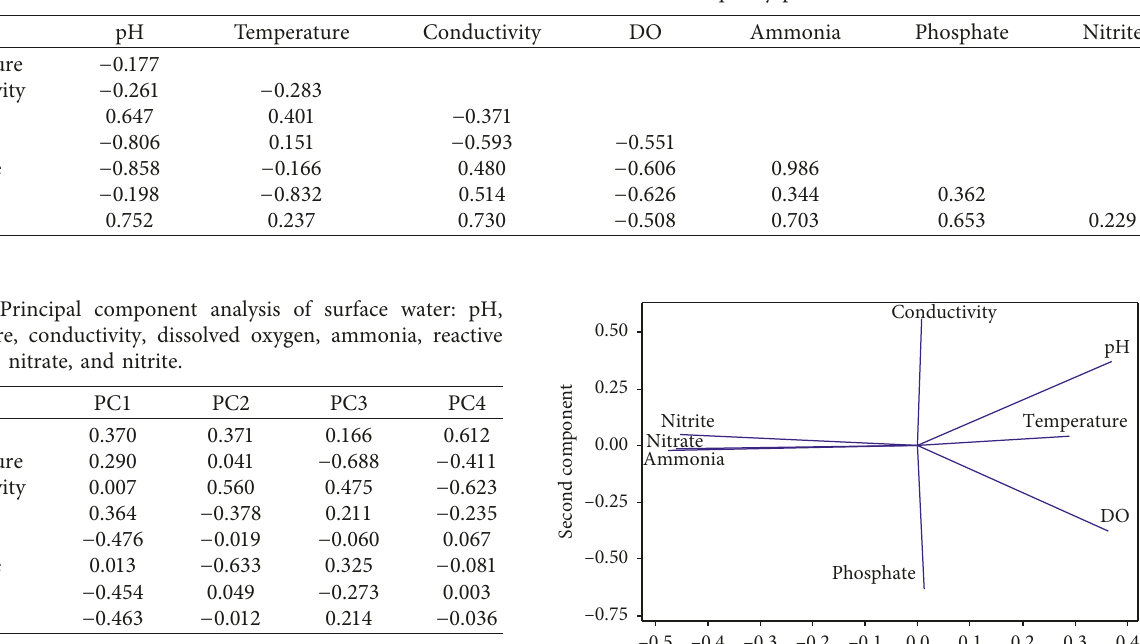
Table 2: Pearson’s correlation coefficient for bottom water quality parameters.